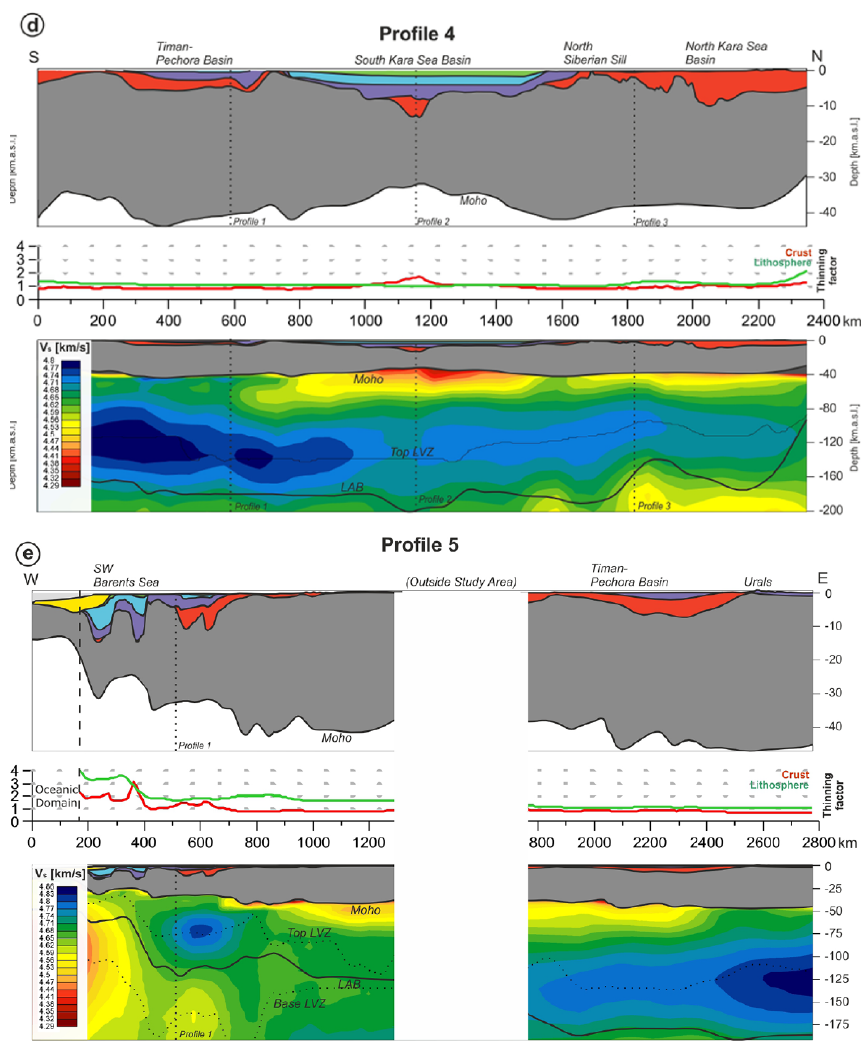
Figure 6. Five profiles illustrating the main geological units and the velocity structure (BARMOD, CUB1.0) on crustal and lithosphere scale (for location see Fig. 1b; LVZ – low velocity zone). The thinning factors are calculated with reference values of 32 and 200km for the crystalline basement and the lithospheric mantle, respectively. Vertical exaggeration of the crustal-scale profiles: 5 × , vertical exaggeration of the lithosphere-scale profiles: 3 ×